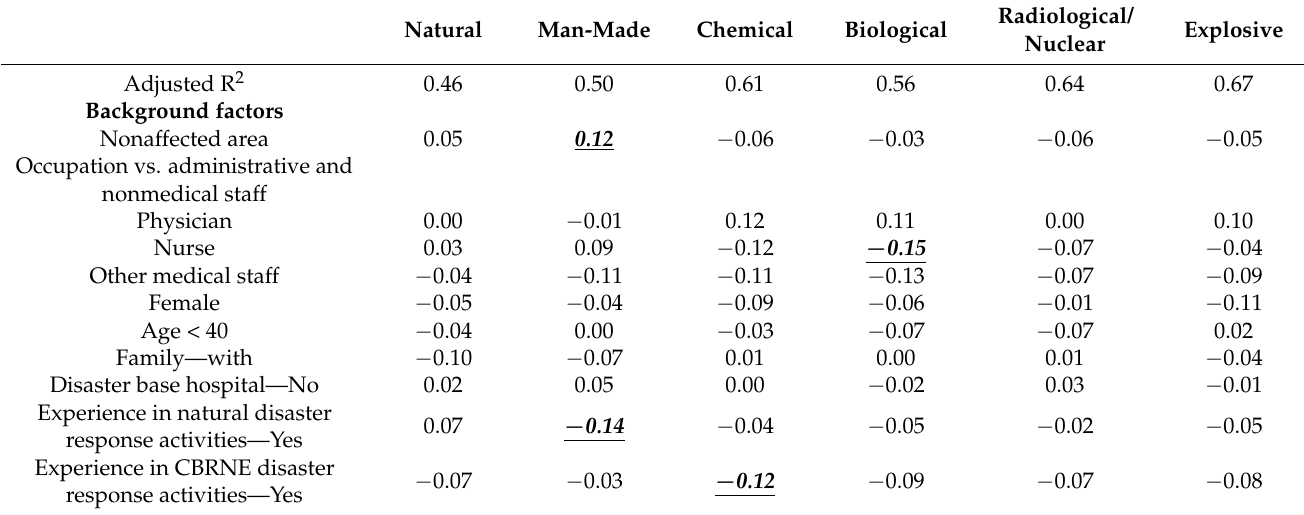
Table A2. Results of Multiple Regression Analysis on Intent to Engage for each